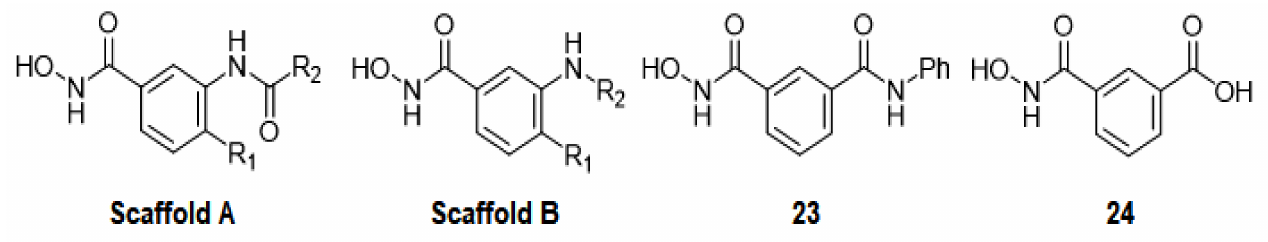
Figure 7. Chemical structures of novel sm HDAC8 inhibitors used as external test